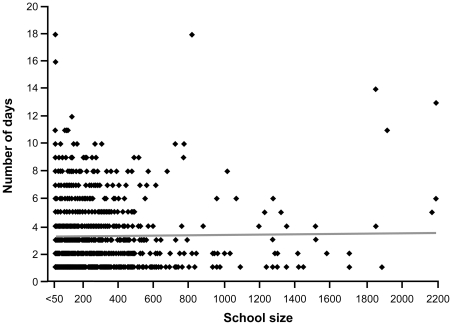
Distribution of the number of days of reporting by school size (all schools) and regression line.